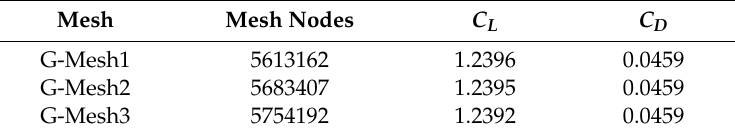
Table 2. Grid independence of BSG.